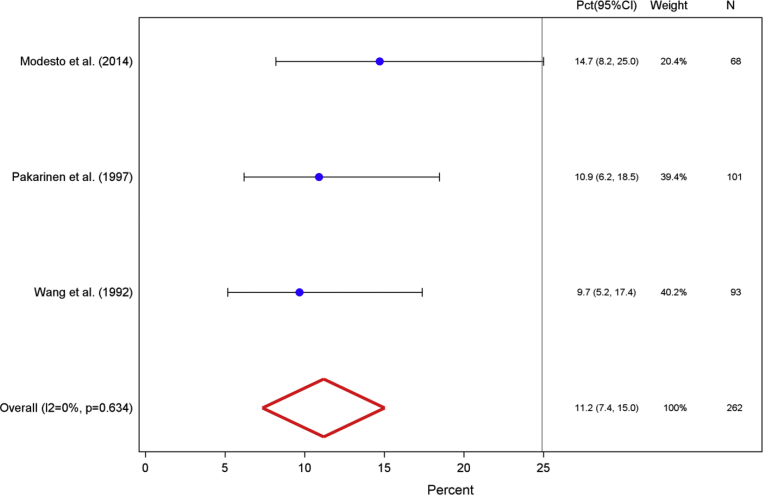
Days 181–271Weighted percentage of levonorgestrel intrauterine system users who experienced amenorrhea, excluding Darney et al,27 for the third interval after insertion.CI, confidence interval; Pct, percentage.Sergison and Maldonado. Amenorrhea associated with LNG-IUS use. Am J Obstet Gynecol 2019.